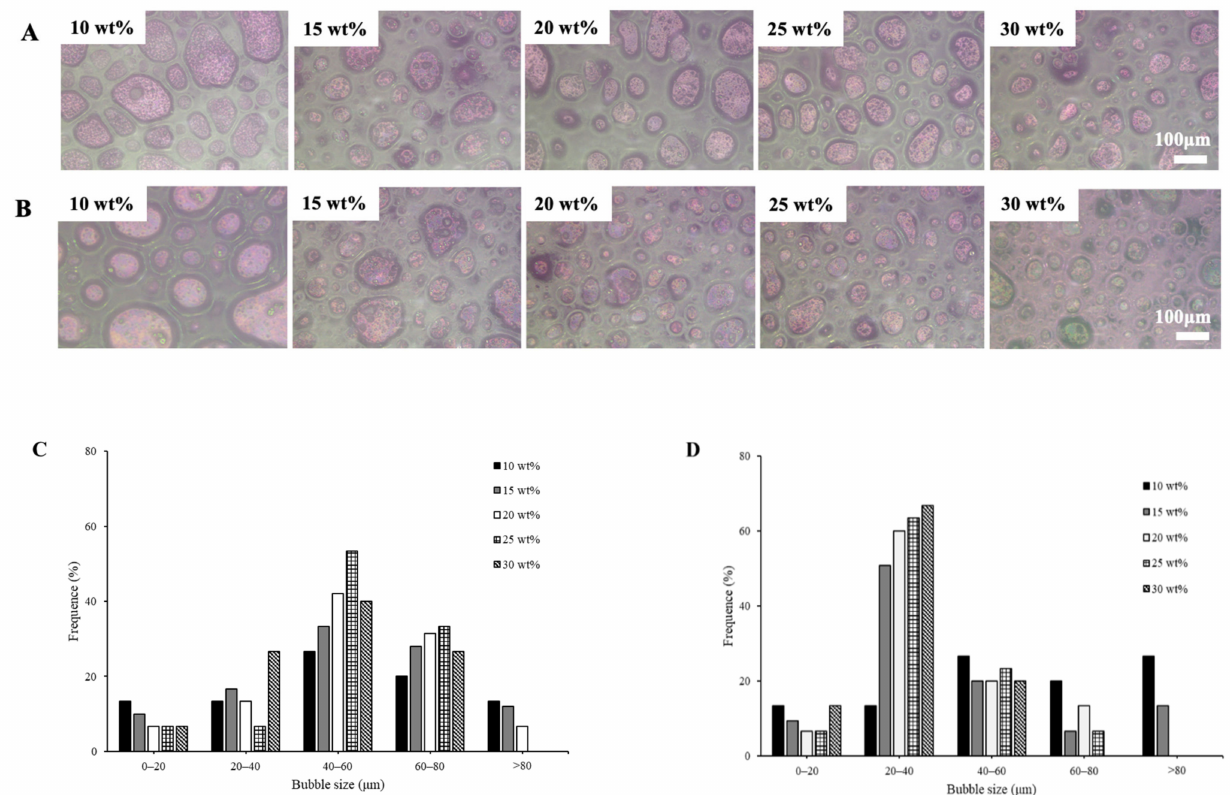
Figure 7. PLM images and the corresponding air bubble frequency distributions of whipped creams at different sugar concentrations. (( A , B ) represent polarized optical microscopic images of whipped creams with glucose ( A ) and corn syrup ( B ). ( C , D ) represent the corresponding air bubble frequency distributions of whipped creams with glucose ( C ) and corn syrup ( D